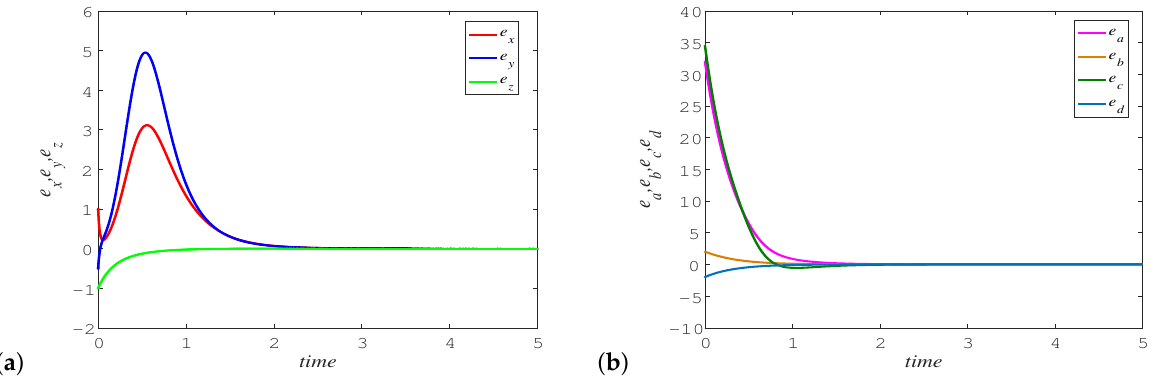
Figure 18. Time evolution of ( a ) synchronization errors e x , e y , and e z , and ( b ) parameter estimation errors e a , e b , e c , and e d